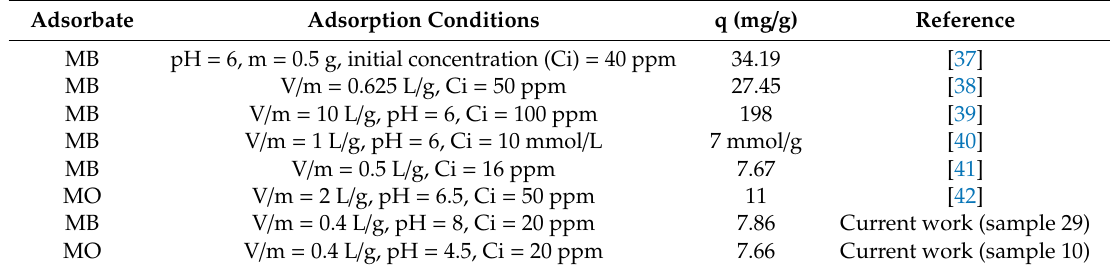
Table 4. Adsorption of MB and MO by ZnO reported in the